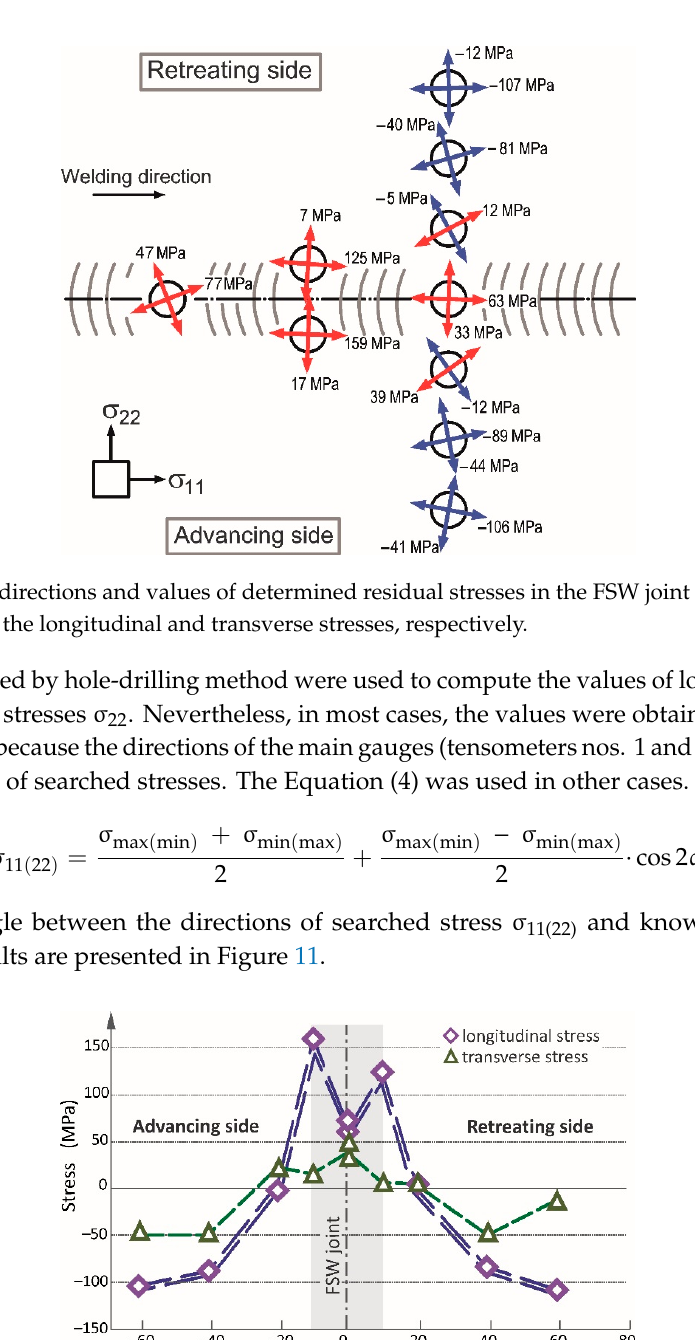
Figure 11. The distribution of longitudinal and transverse stresses in the FSW joint and its vicinity. The results shown in Figure 11 indicate that tension stresses are present in the joint and its nearest vicinity. Greater values of stresses are in a longitudinal direction than transverse; additionally, they are greater on the advancing side than the retreating side. As the retreating side is characterized by higher heat input, it promotes stress relaxation and can explain the lower value of residual stress in this zone of the weld [40,41]. The highest stresses are at the weld line on the advancing side (159 MPa). The stresses in a joint center reach of 33–77 MPa and are similar in all directions. At the distance of approximately 10 mm from the weld joint, the stresses have very low values, near to zero. It should be noted that at these points the direction of principle stresses is the most rotated of all. It is probably caused by the material flow during the stirring process resulting in